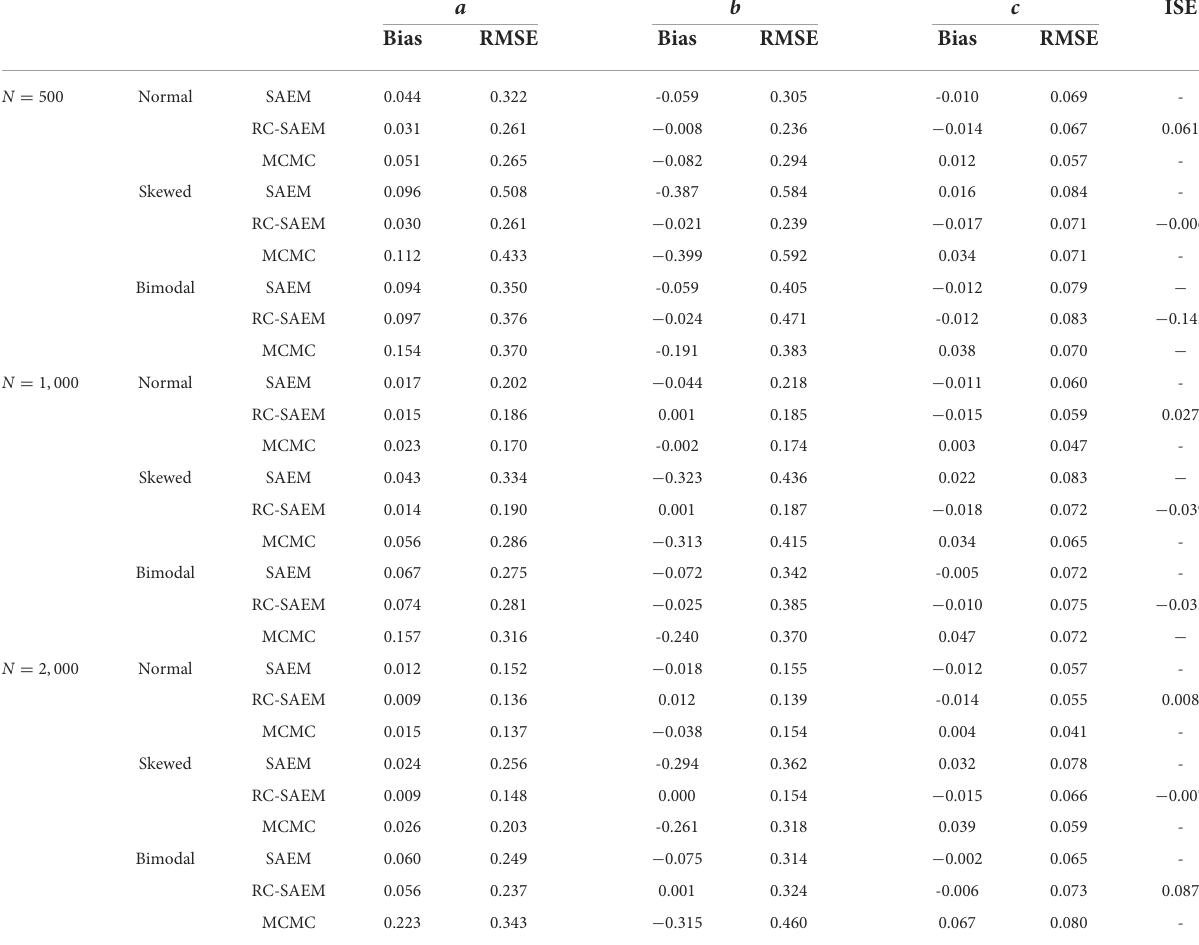
TABLE 5 Bias and RMSE of the item parameter estimates and the values of ISE statistic under different ability densities when the test length is 30. a b c ISE Bias RMSE Bias RMSE Bias RMSE Normal